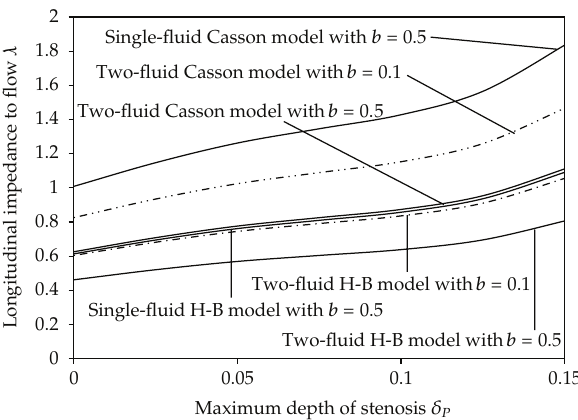
Figure 11: Variation of longitudinal impedance to flow with maximum depth of the stenosis for two-fluid H-B and Casson models and di ff erent values of b with B (cid:7) 1, ψ (cid:7) − 0 . 1, t (cid:7) 60 ◦ , β (cid:7) n (cid:7) 0 . 95, θ (cid:7) δ P (cid:7) 0 . 1, φ (cid:7) α (cid:7) α H (cid:7) α C (cid:7) 0 . 2, and b (cid:7) 0 .